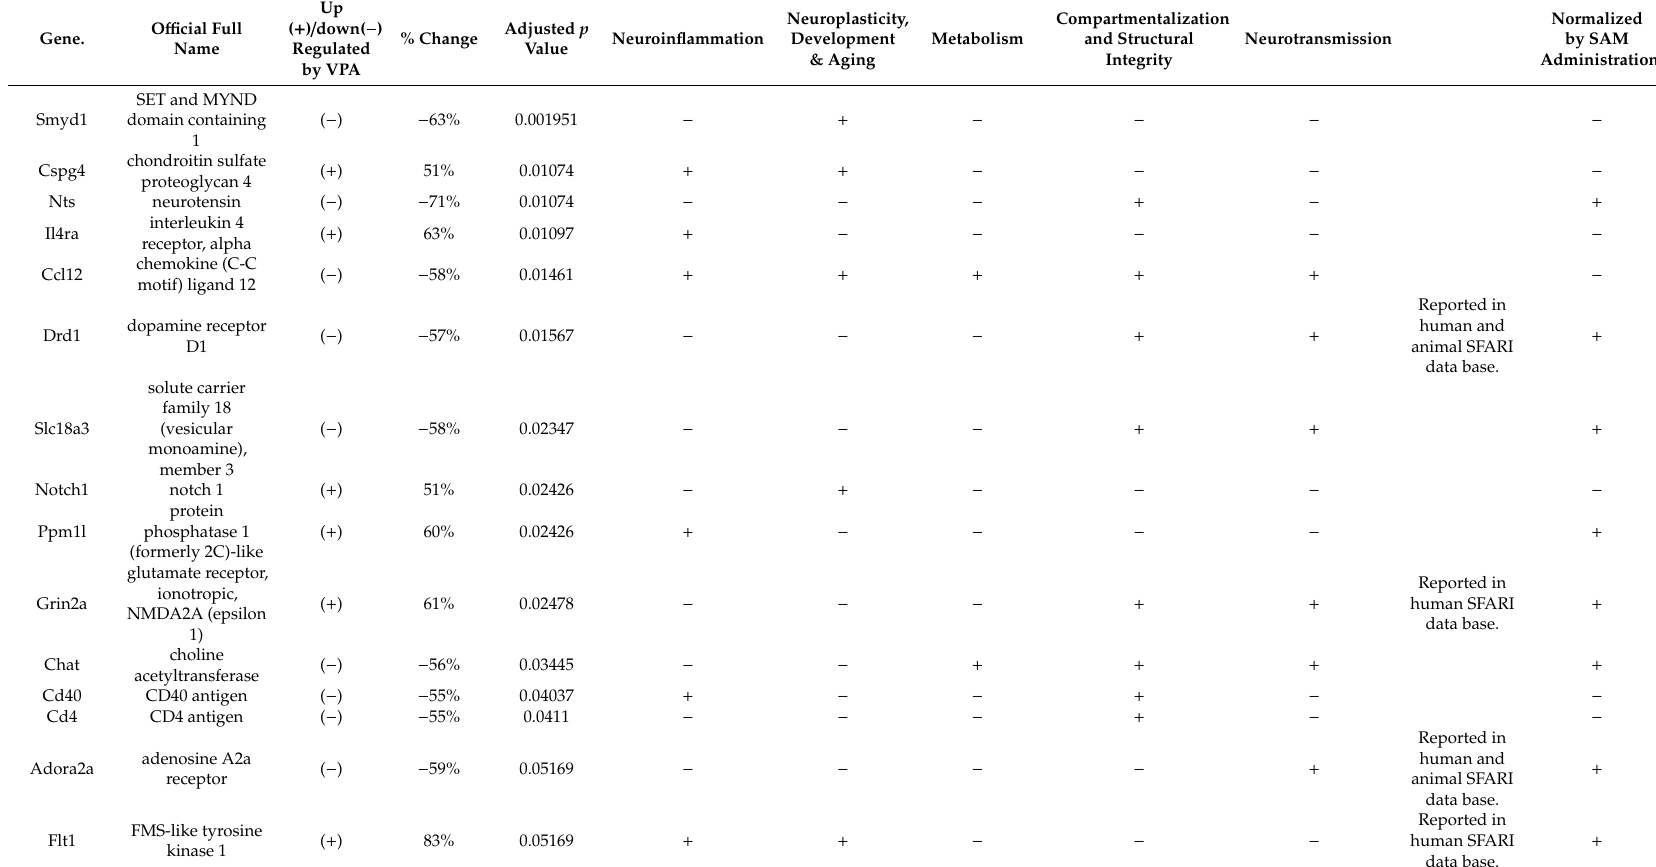
Table 2. Genes changed by VPA at least by 50% in females and the normalization by SAM *.